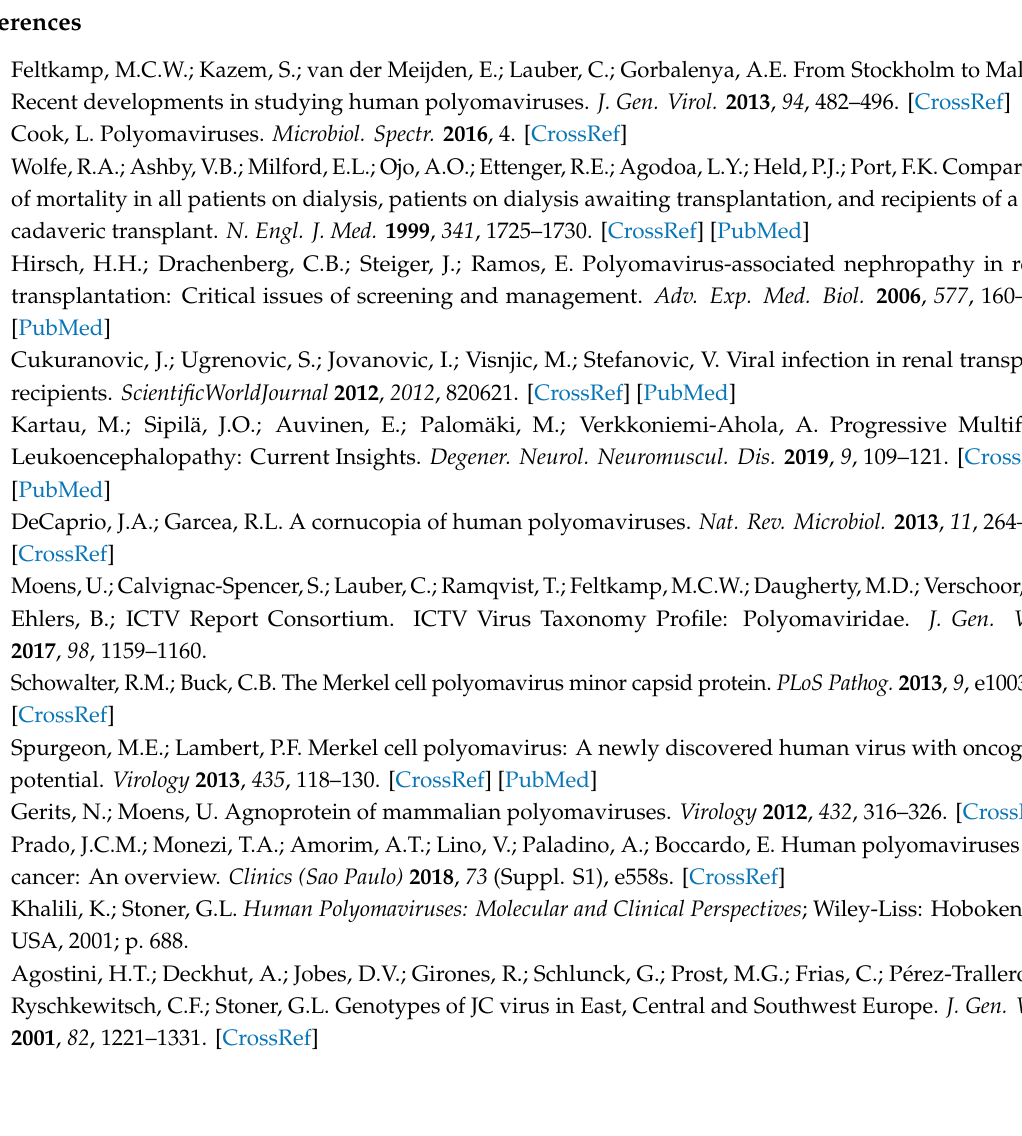
Table S1: Primer sequences for HPyVs nested PCR, Table S2: Thermal profiles for NCCR HPyVs nested PCR, Table S3: Thermal profiles for VP1 HPyVs nested PCR, Figure S1: Sequence of the JCPyV Viral protein 1 (VP1) gene amplified from urine samples (nucleotide 1710-1924; ACCESSION NC_001699), Figure S2: Sequence of the BKPyV Viral protein 1 (VP1) gene amplified from urine samples (nucleotide 1681-1958; ACCESSION V01108